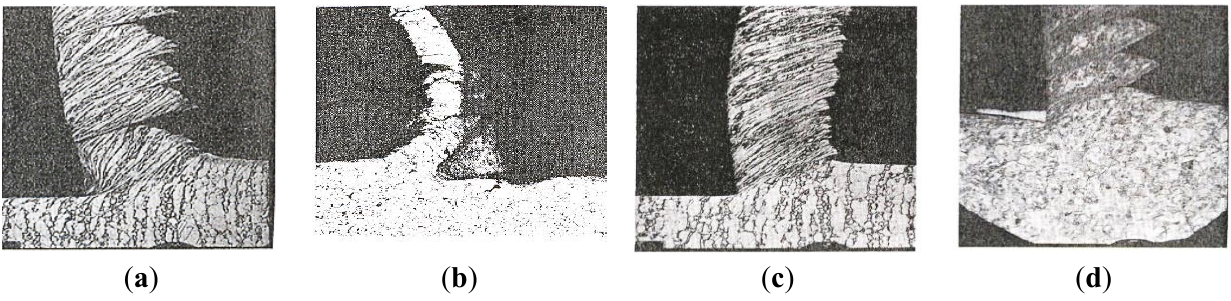
Figure 6. ( a ) Discontinuous chip, Cutting speed +; ( b ) continuous over a built-up edge, Cutting speed ++; ( c ) continuous chip, Cutting speed +++; and ( d ) segmented chip [13], Cutting speed